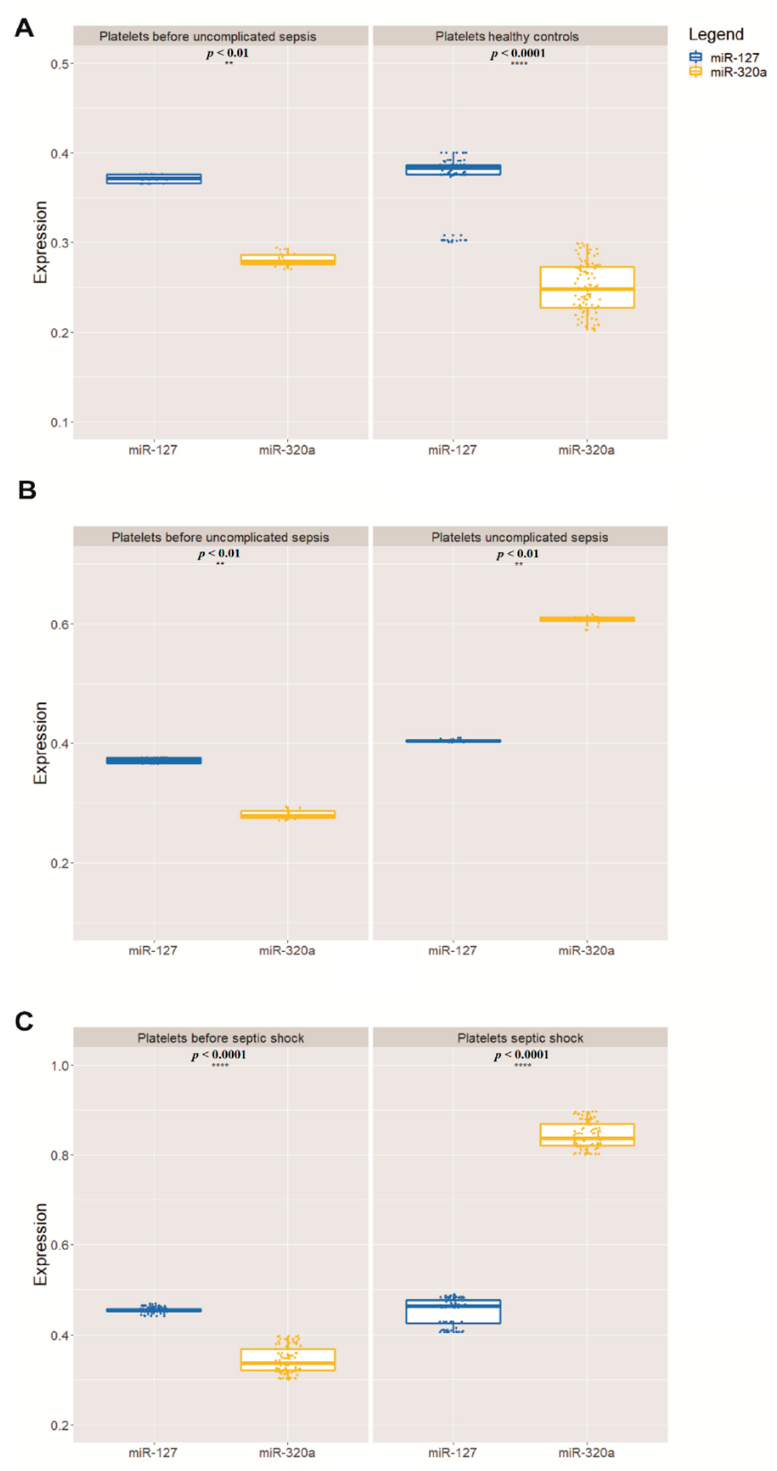
Figure 1. Relative mean expression of miRNAs quantitative PCR (qPCR) analysis ( A ). The Wilcoxon paired-sample test was applied to estimate the significance of expression of miR-127 and miR-320a in relation to miR-191 ( B ), which has been used as an internal control for validation analysis (** p < 0.01, **** p < 0.0001) ( C ). In all graphs, the X-axis represents the storage time of the PCs and the Y-axis represents the 100 PC